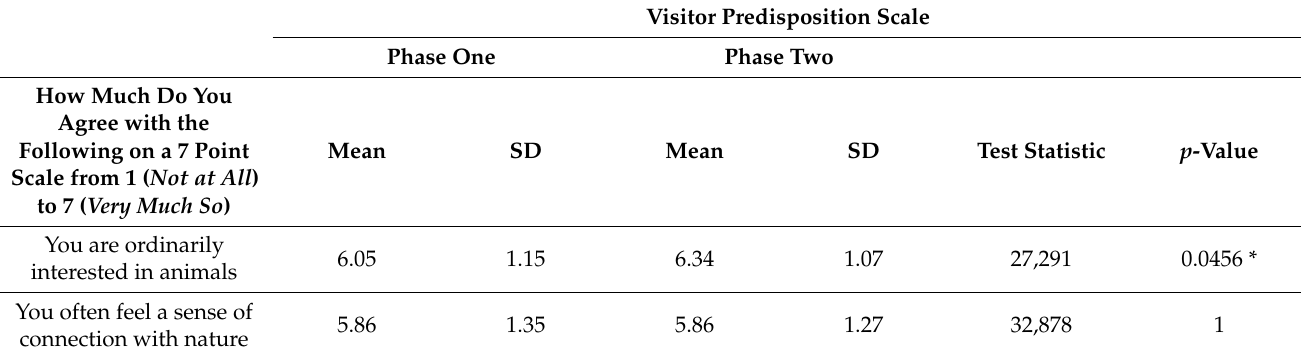
Table 1. Mean responses to survey questions before and after the introduction of new giraffes. p values < 0.05 *; p values < 0.005